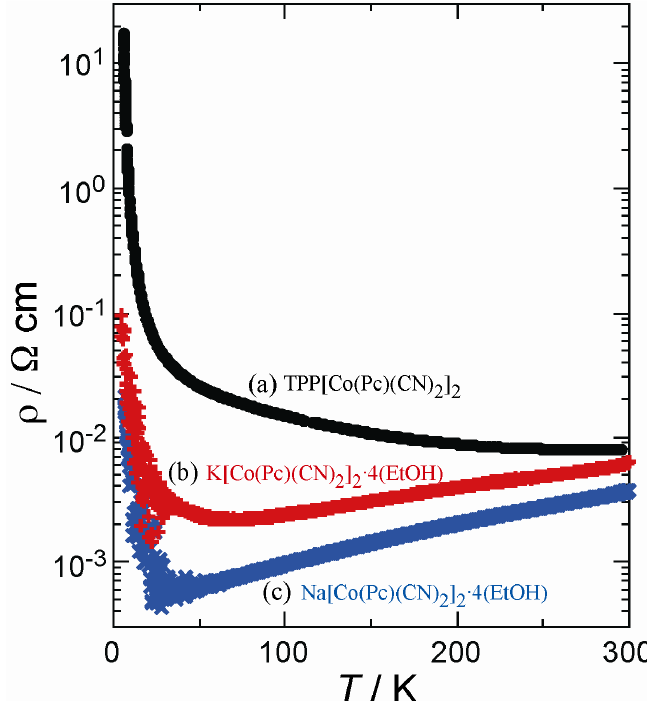
Figure 5. Temperature dependence of the electrical resistivity along the c axis in